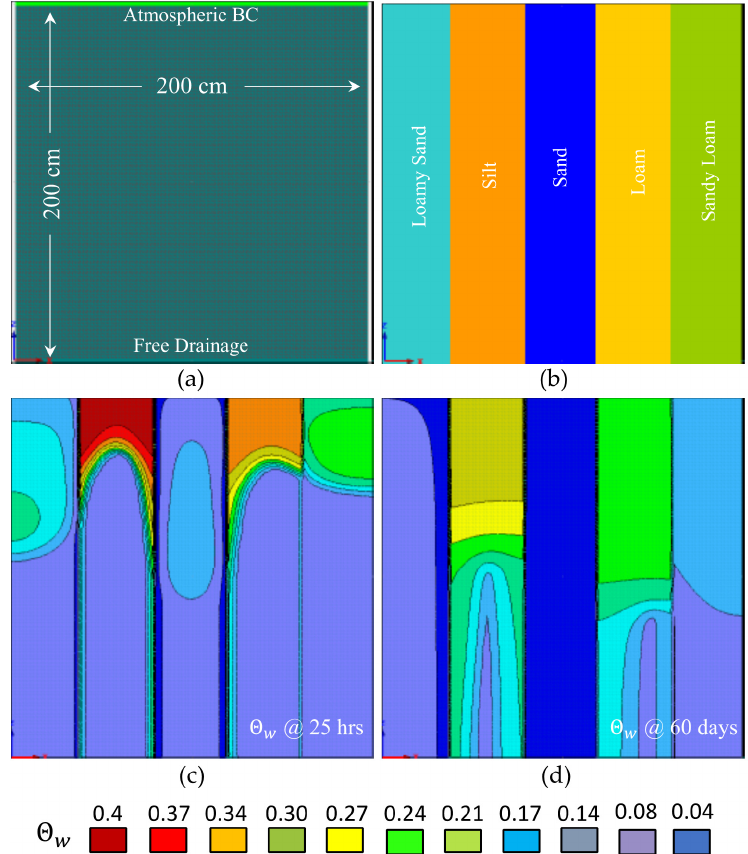
Figure 12. Boundary conditions ( a ), heterogeneity structure ( b ), and simulated temporal changes in 𝛩 (cid:3050) at 25 h ( c ) and 60 days ( d ) for the 2D simulations.